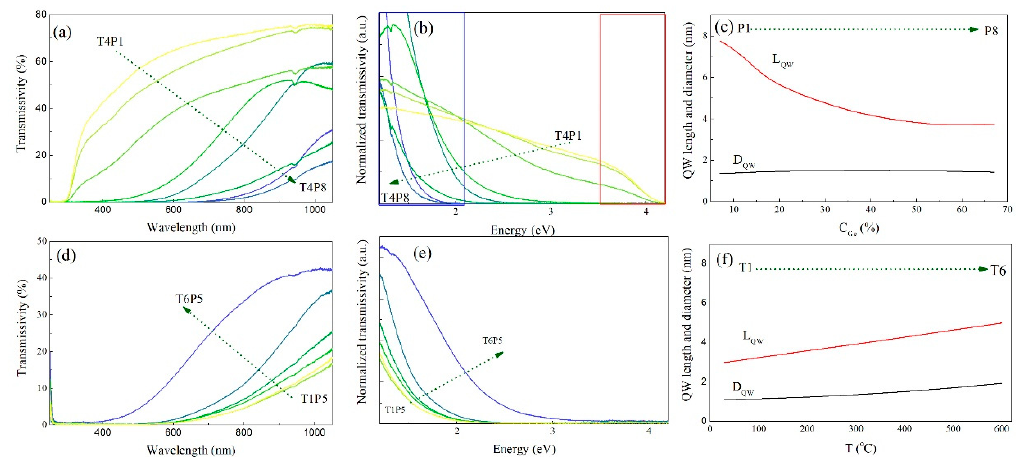
Figure 7. ( a ) Transmissivity, ( b ) normalized transmissivity, and ( c ) geometrical parameters of the materials prepared at 400 °C (T4), but with the varying Ge concentrations P1–P8. The marked areas in ( b ) at smaller and larger energies mark the rapid transmissivity decrease near the band gap energies of the bulk and confined Ge, respectively. ( d ) Transmissivity, ( e ) normalized transmissivity, and ( f ) geometrical parameters of the materials prepared with the same Ge sputter power P5 (15 W), but with the varying deposition temperatures of T1–T6.